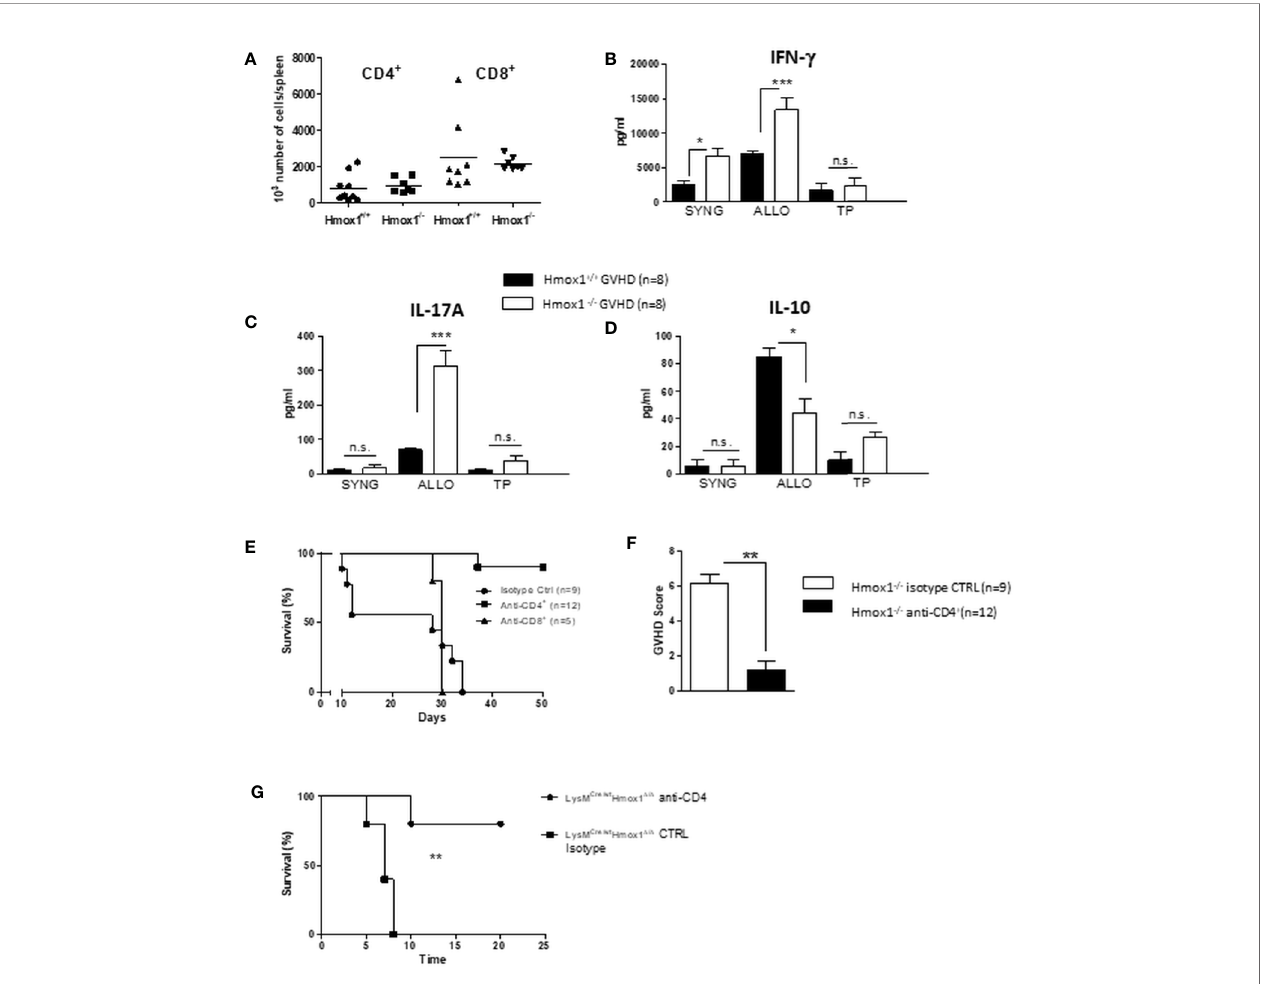
FIGURE 3 | Donor-derived myeloid HO-1 controls T cell alloreactivity. (A) The number of donor-derived CD4+ and CD8+ T cells was quanti fi ed by fl ow cytometry at day 7 post-transplantation in C57BL/6 hosts grafted with Hmox1 − / − BM and WT BALB/c T cells ( Hmox1 − / − GVHD) and compared with controls (WT GVHD). (B – D) Spleen cells from Hmox1 − / − versus Hmox1 +/+ BM reconstituted hosts were cultured with donor type (SYNG: syngeneic BALB/c), host type (ALLO: allogeneic C57BL/6), or third party (TP) (CBA/Ca) irradiated stimulatory cells. IFN- g , IL-17A, and IL-10 were measured in MLR supernatants. Two independent experiments involving 8 animals per group were pooled. (E, F) The effects of either CD4+ or CD8+ T cell depletion (see materials and methods) on host survival and GVHD score are shown in the BALB/c ( Hmox1 − / − versus Hmox1 +/+ BM) to C57BL/6 graft versus host combination. (G) The effect of CD4+ depletion on host survival in the BALB/c recipients transplanted with BM from C57BL/6 LysM Cre/wt Hmox1 D / D mice. n.s., no signi fi cant difference; * P <.05; ** P <.01; *** P